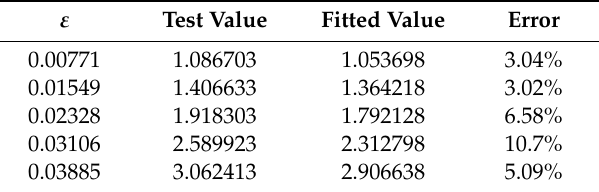
Table 14. The deviation between the test and calculated values for specimen 2 under 500 ◦ C. ε